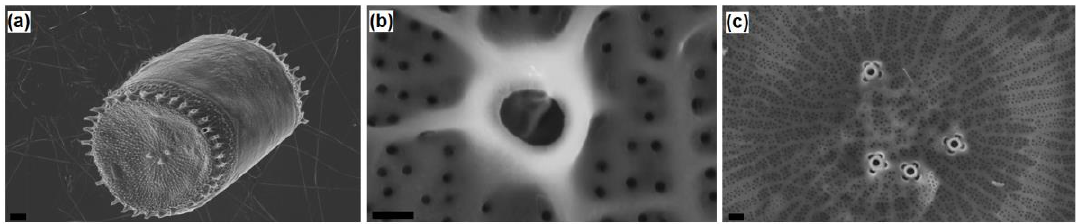
Figure 1. Scanning electron microscopy (SEM) images of a Thalassiosira weissflogii frustules: ( a ) after soft-acid treatment (1 h in HCl-MeOH) the whole structure is preserved; ( b , c ) after hard acidic oxidative treatment (4 h in H 2 SO 4 -H 2 O 2 ), the intricate pattern of pores is clearly visible. Markers: ( a ) 1 µm; ( b ) 100 nm; ( c ) 200 nm.